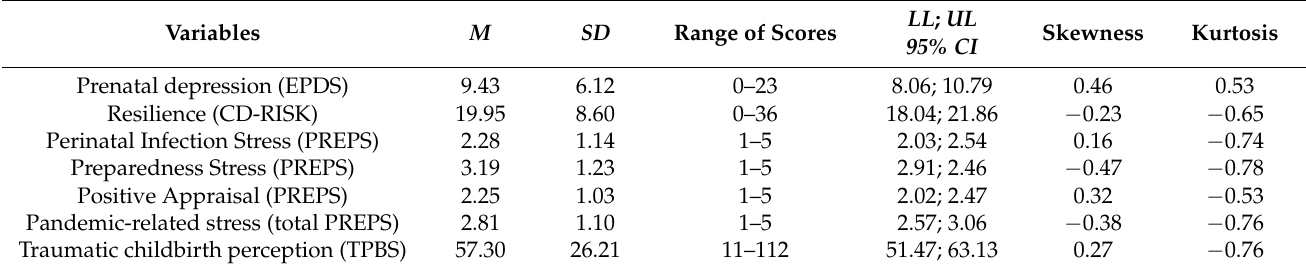
Table 4. Descriptive statistics of analyzed variables ( N =